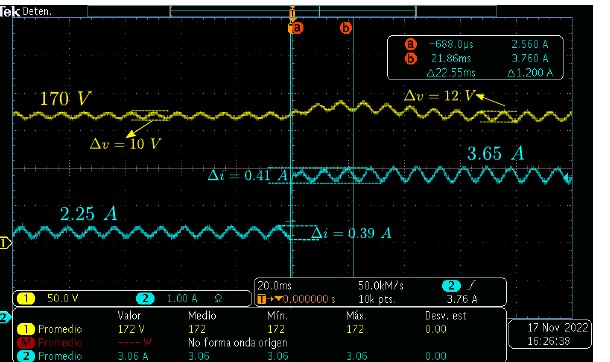
Figure 11. Performance of the current controller with reference changes and bus voltage